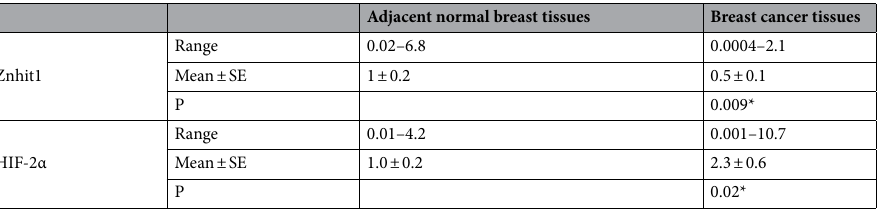
Table 1. Statistical analyses of Znhit1 and HIF-2α gene expression in BC tissues and adjacent normal breast tissues. P P value for comparing between BC tissues and adjacent normal breast tissues. *Statistically significant difference at P ≤ 0.05.